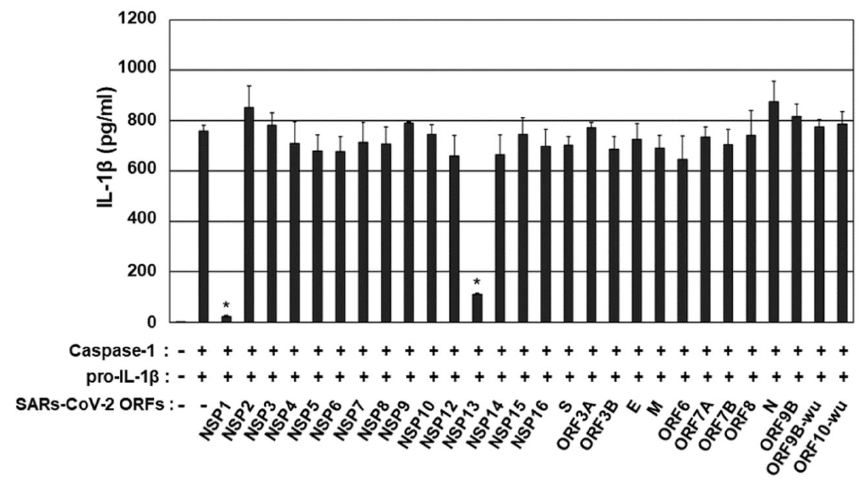
Figure 1. Screening of severe acute respiratory syndrome coronavirus 2 (SARS-CoV-2) open reading frames (ORFs) that regulate caspase-1-mediated IL-1β production. Human embryonic kidney 293T (HEK 293T) cells were co-transfected with vectors expressing caspase-1 and pro-IL-1β, plus either pEF1α-DEST or pEF1α-DEST expressing complementary DNAs (cDNAs) encoding 28 SARS-CoV-2 ORFs. After 24 h, mature IL-1β in culture supernatants was measured by enzyme-linked immunosorbent assay (ELISA). * p < 0.001 by unpaired two-tailed Student’s t -tests. Data shown are representative of three independent experiments.